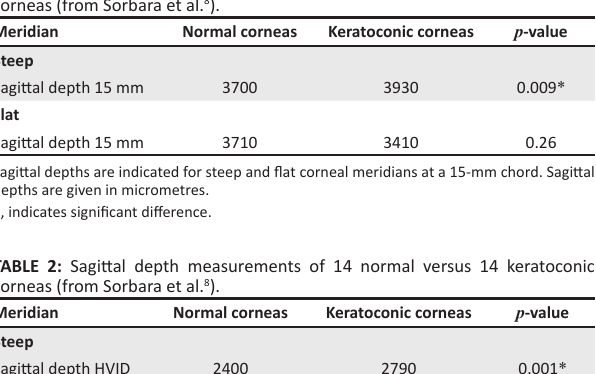
S and S are the relevant 1, 2 3